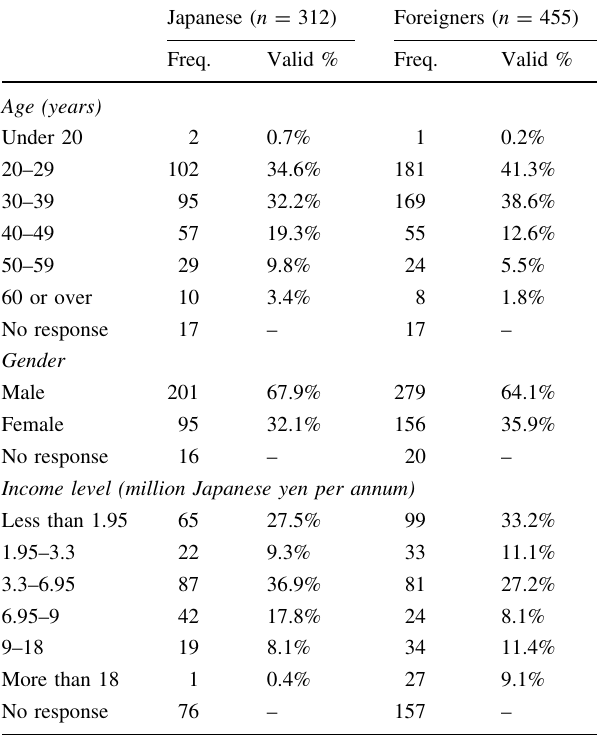
Table 5 Demographic characteristics of extracted Japanese